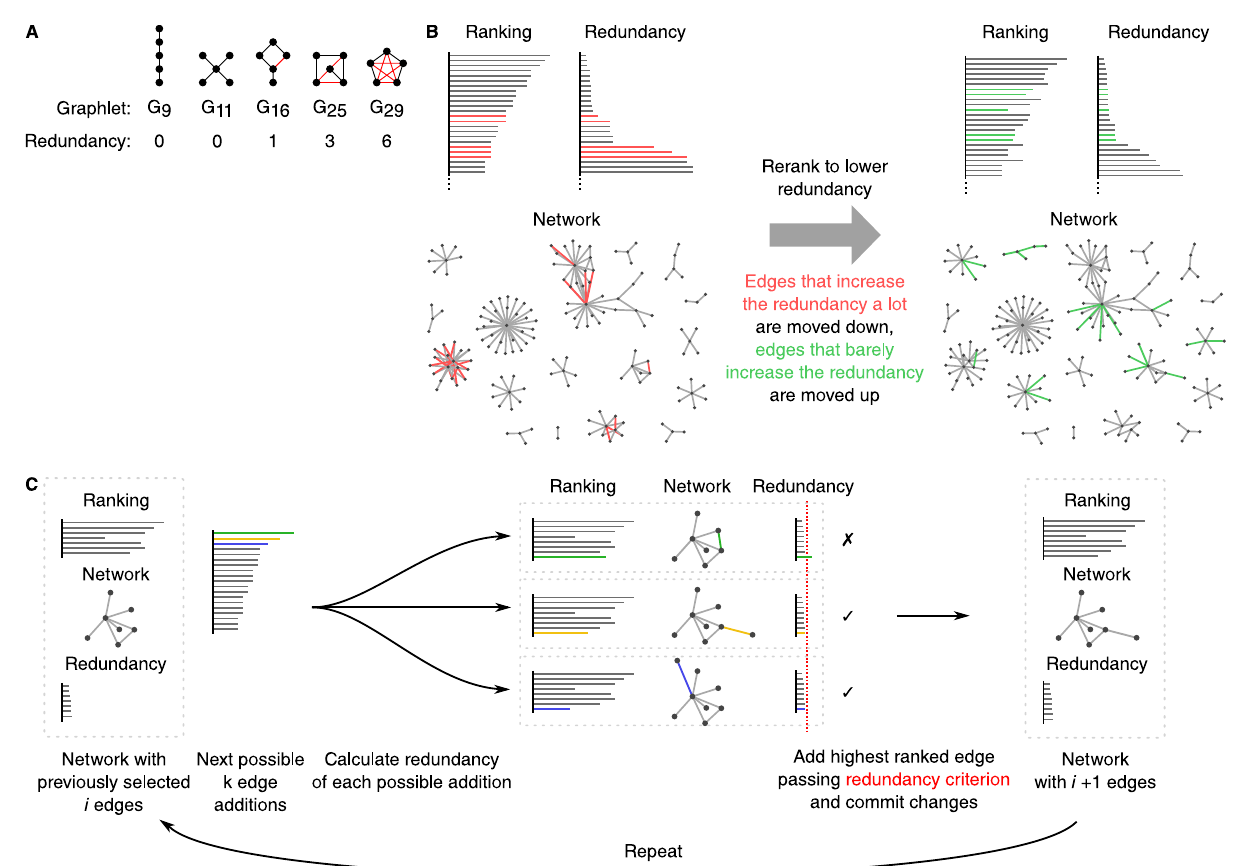
Fig 4. Predicted gene regulatory networks of model organisms are optimised to reduce the false positive rate. A) The number of redundant edges in each graphlet are counted. B) The network is optimised in order to obtain a lower redundancy over time. Two networks are shown, one before and one after the optimisation procedure. Edges coloured in red have been removed from the network after optimisation, green edges have been added. C) Starting from an empty network, the interactions are modified by iteratively evaluating the increase in redundancy of the next k interactions, and adding the first edge for which its redundancy is less than the 90 th percentile